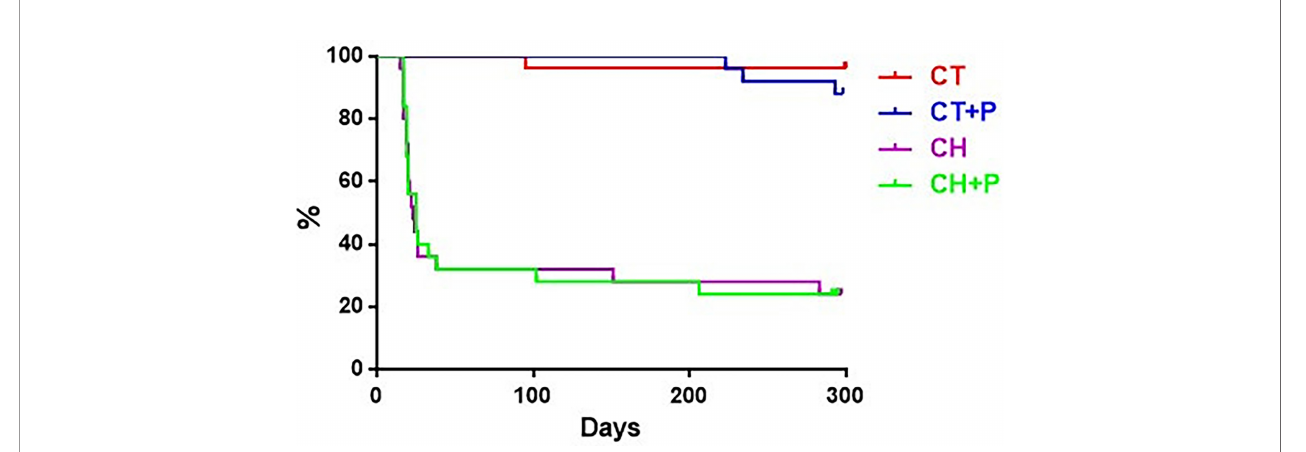
FIGURE 9 | Graph of animal survival at 10 months compared to study groups. CT - control group (n=25), CT+P – control group exposed to pollution (n=25), CH – chagasic group (n=25), CH+P – chagasic group exposed to pollution